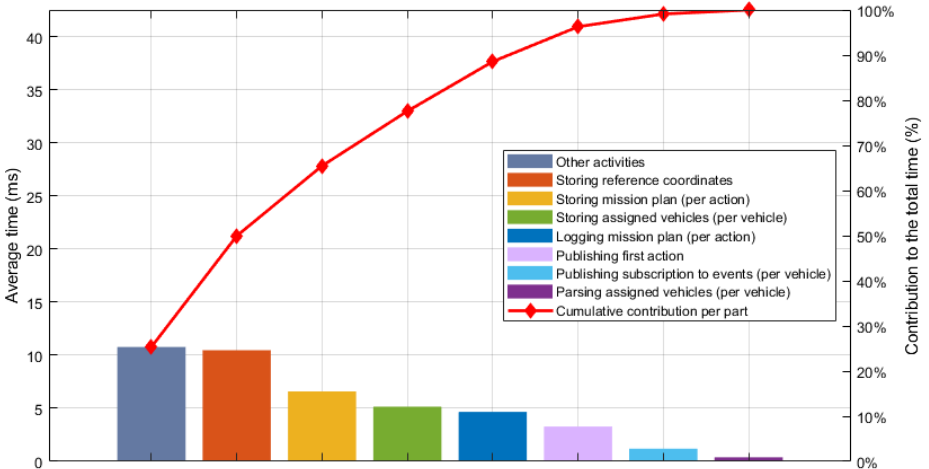
Figure 31. Pareto chart for the average distribution of time for each activity performed by the MTRR when starting a mission, averaged to the number of actions in the mission plan and the number of vehicles as appropriate.